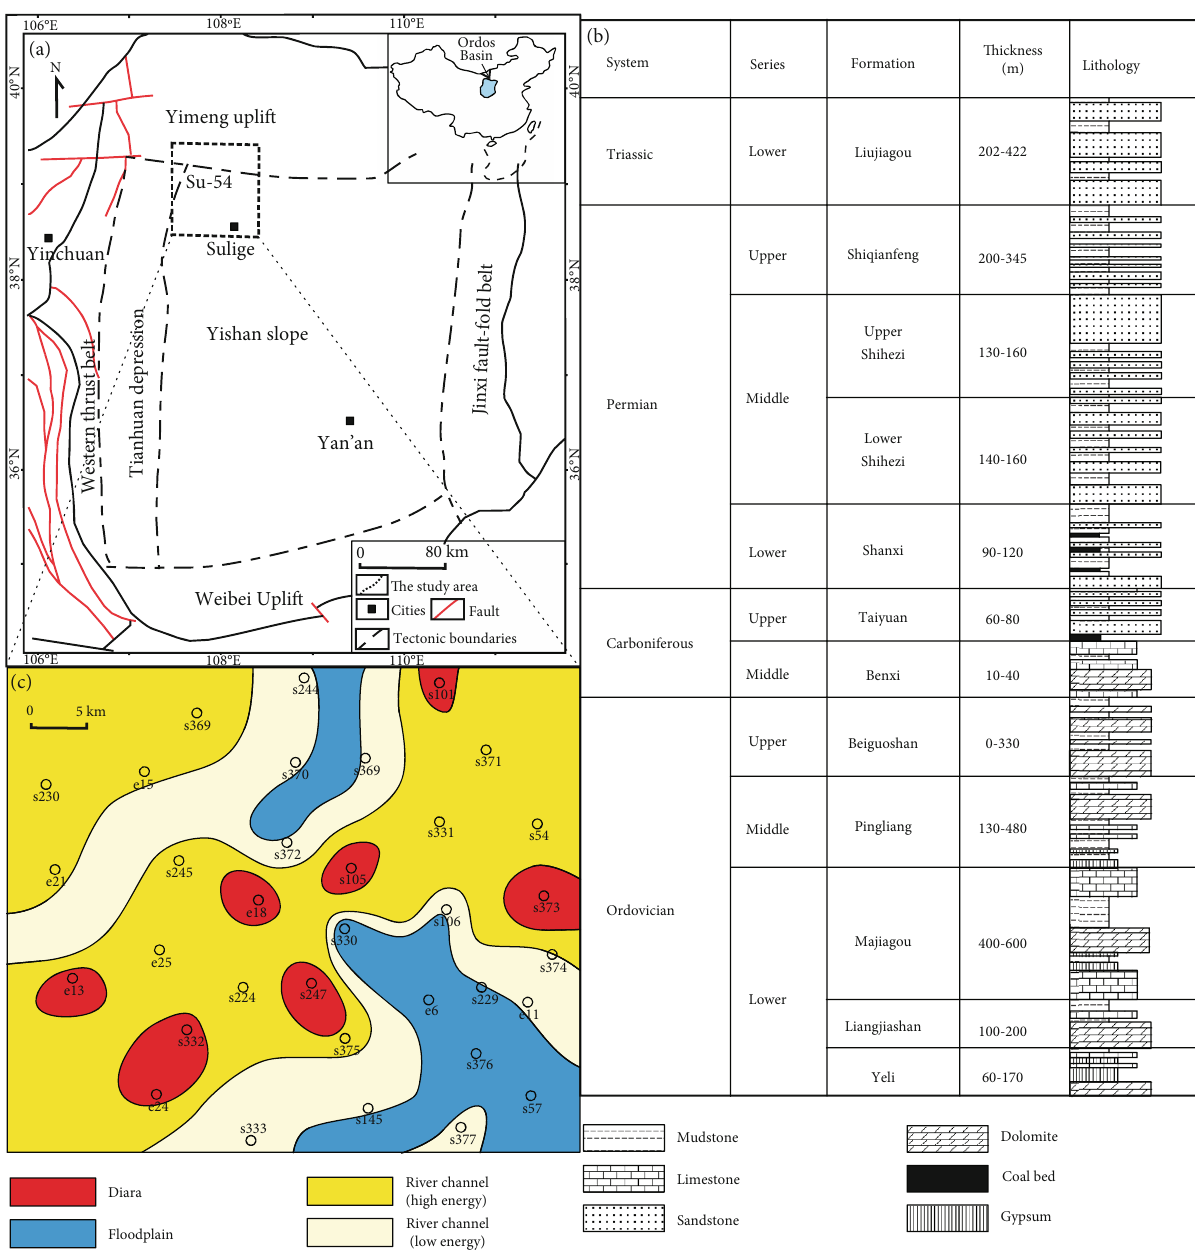
Figure 1: (a) Structural location of the study area in the western Sulige gas fi eld (modi fi ed from Xie et al. [19]), (b) stratigraphic column from the Ordovician Majiagou Formation to the Triassic Liujiagou Formation in the northern Ordos Basin (modi fi ed from [28, 29]), and (c) sedimentary facies of P sh h 82 in the Su-54 2